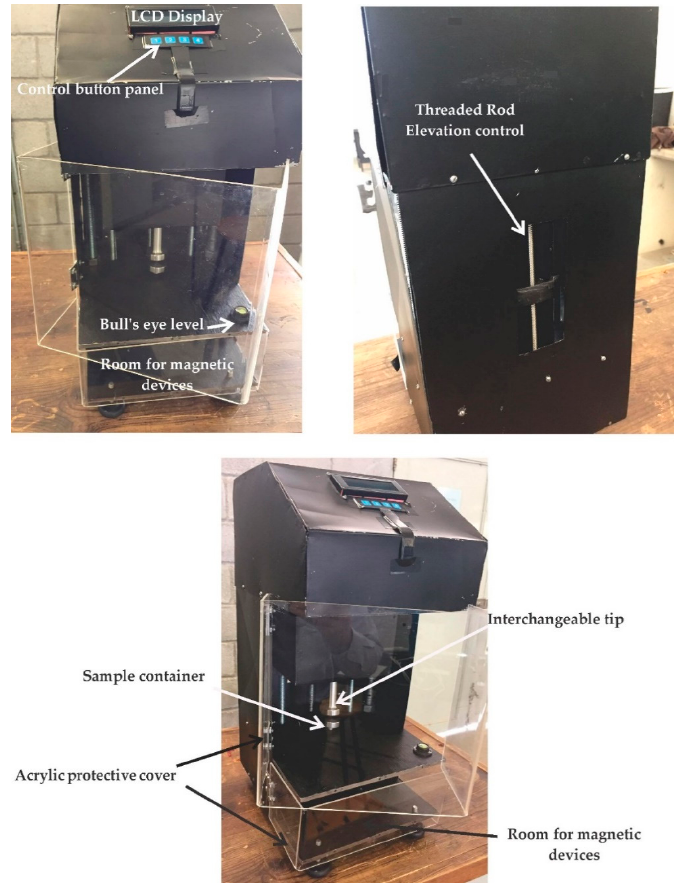
Figure 15. Manufactured rheometer—final version. Product specifications: power source 110V, sensor power source 12 V, variable speed operation from 0 to 1000 RPM, interchangeable test probes, ability to incorporate attachments to perform electro- and magneto-rheological